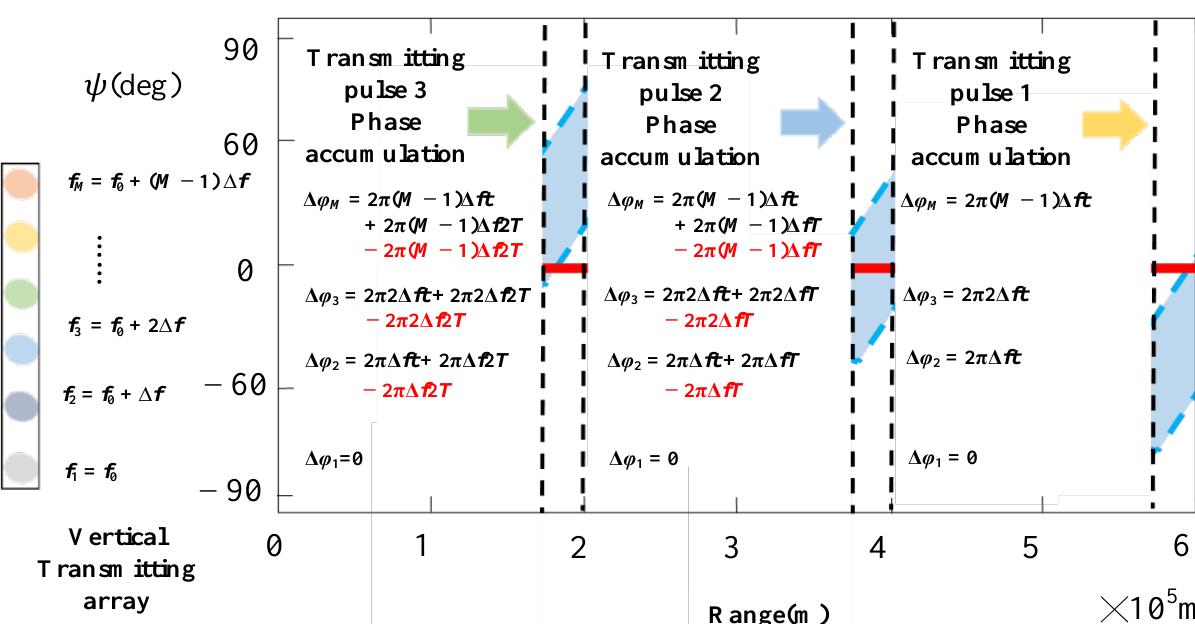
Figure 3. Schematic diagram of main lobe moving correction of emission pattern. The main lobe rectification weighting vector added to each array element is con- structed as follows when transmitting signals: